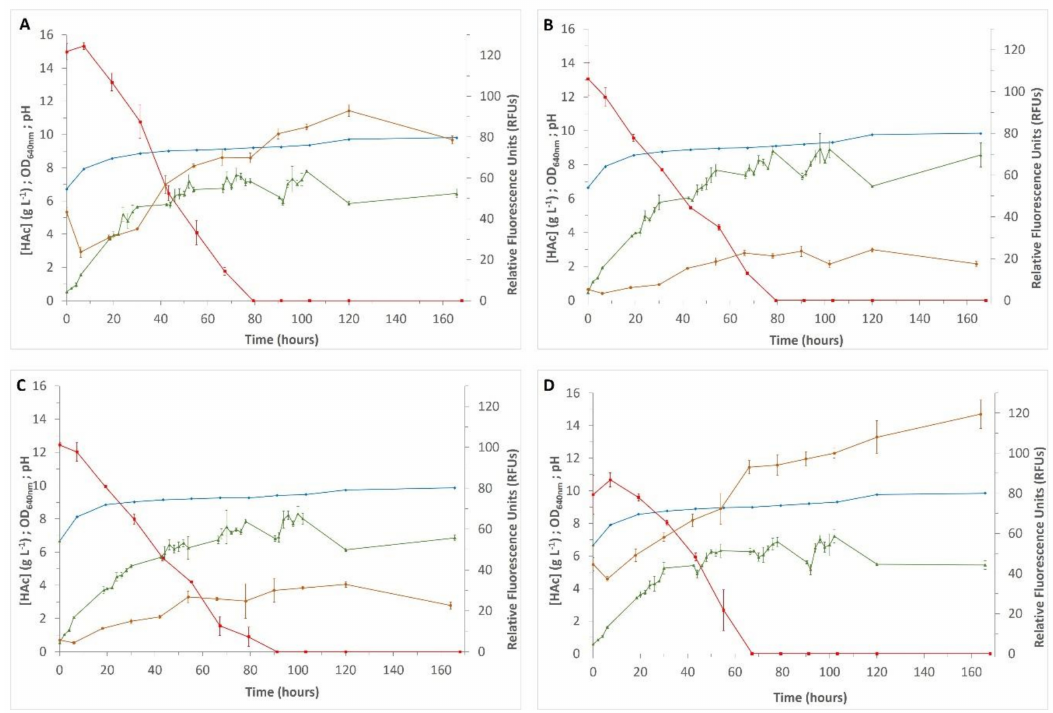
Figure 1. Time-course growth in YP:HAc 15 g L − 1 medium, during 168 h, using the four tested yeast species: ( A ) Apiotrichum brassicae V134; ( B ) Candida tropicalis V139; ( C ) Metschnikowia pulcherrima V213; ( D ) Pichia kudriavzevii V194. Colors indicate measurements (mean ± standard deviations) of the following characteristics: orange—relative fluorescent units (RFUs); green—optical density (OD_640 nm); blue—pH; red—acetic acid concentration (g L − 1